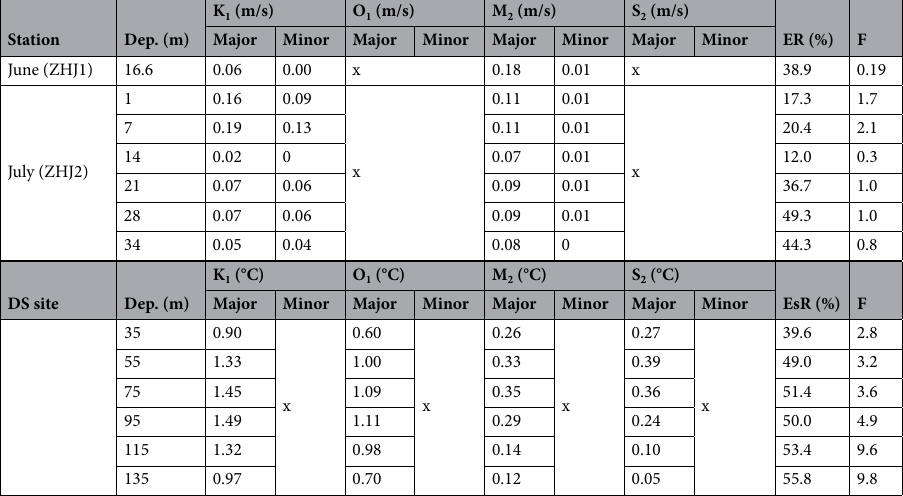
Table 1. The tidal constituents at different depths in in both cruises (June and July) and at DS site. Only the first four tidal components (K 1 , O 1 , M 2 , and S 2 ) are listed in the table. The "x" symbol indicates the amplitude was insignificant or there was lack of data. The ER ratios indicates the tidal-to-total energy ratio, and F means form